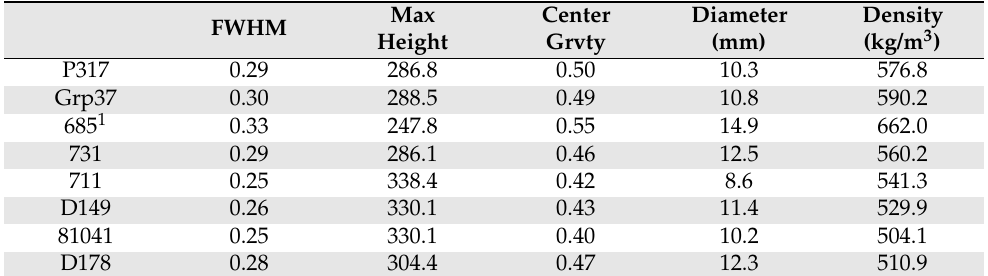
Figure 6. Statistical analysis of fiber characteristics for S. viminalis clones. FWHM: full width at half maximum. Center Grvty: center of gravity. Table 4. Data for Gaussian fit and properties of the S. viminalis clones used for statistical